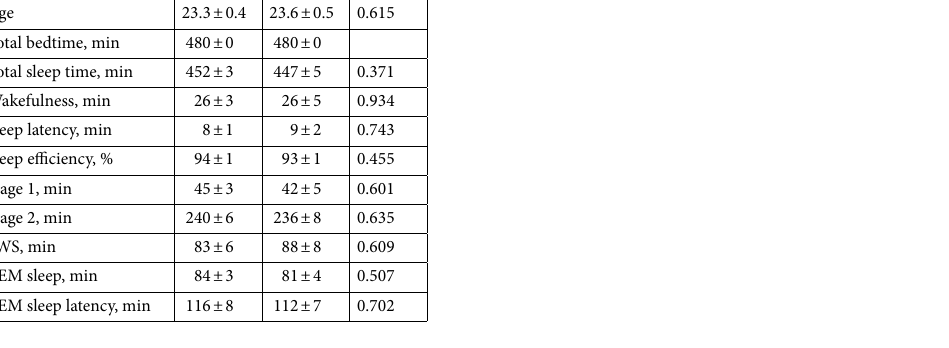
Table 3. Comparison of sleep architecture between men and women. Values are means ± SE for men (n = 34) and women (n = 27) 8,23–25 .